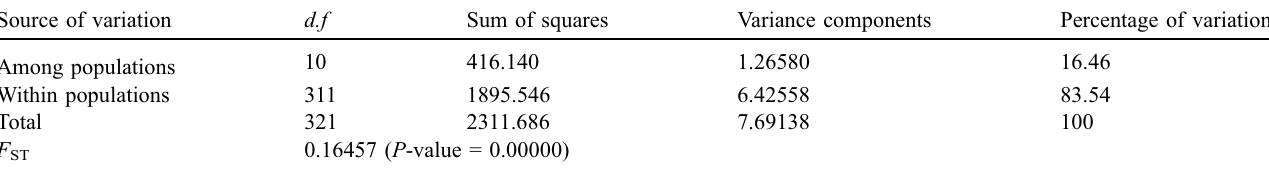
Table 3. Analysis of molecular variance (AMOVA) results for 11 M. nipponense populations. Source of variation d.f